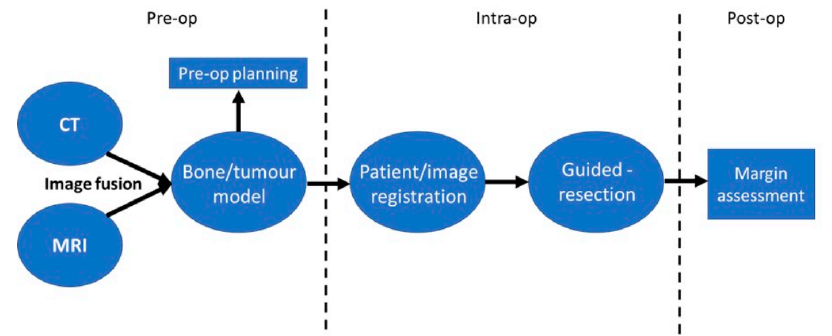
Figure 4. CANS flowchart: adapted from Wong et al.